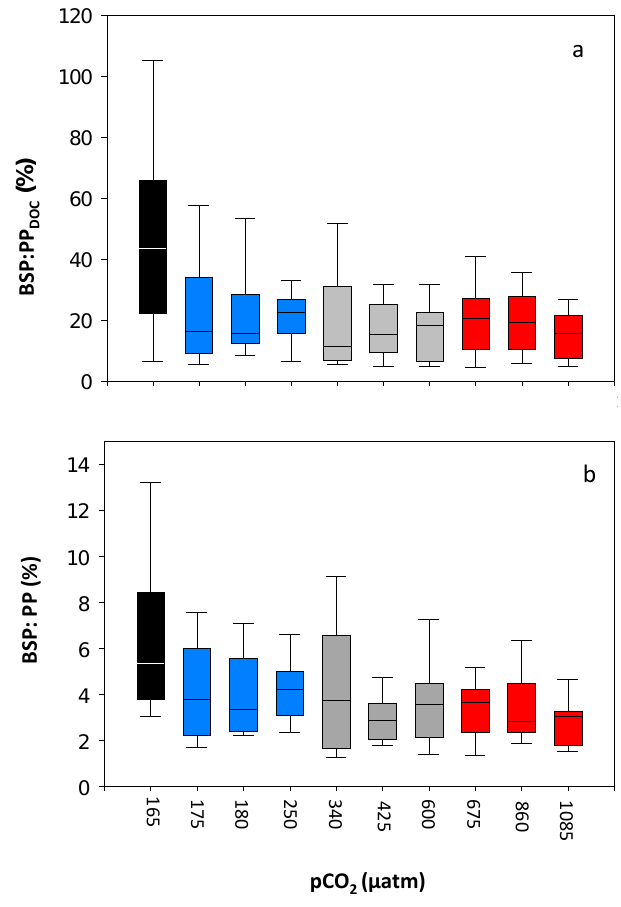
Fig. 13. Box and whisker plots of the ratio of bacterial biomass production (BP) to (a) primary production of DOC (PP DOC ) and to (b) total primary production (PP = PP POC + PP DOC ) as derived from dark and light bottle incubations. Average values (day 5–day 28) for p CO 2 are shown. 14 C-PP. Thus, a potential cause for the discrepancy between